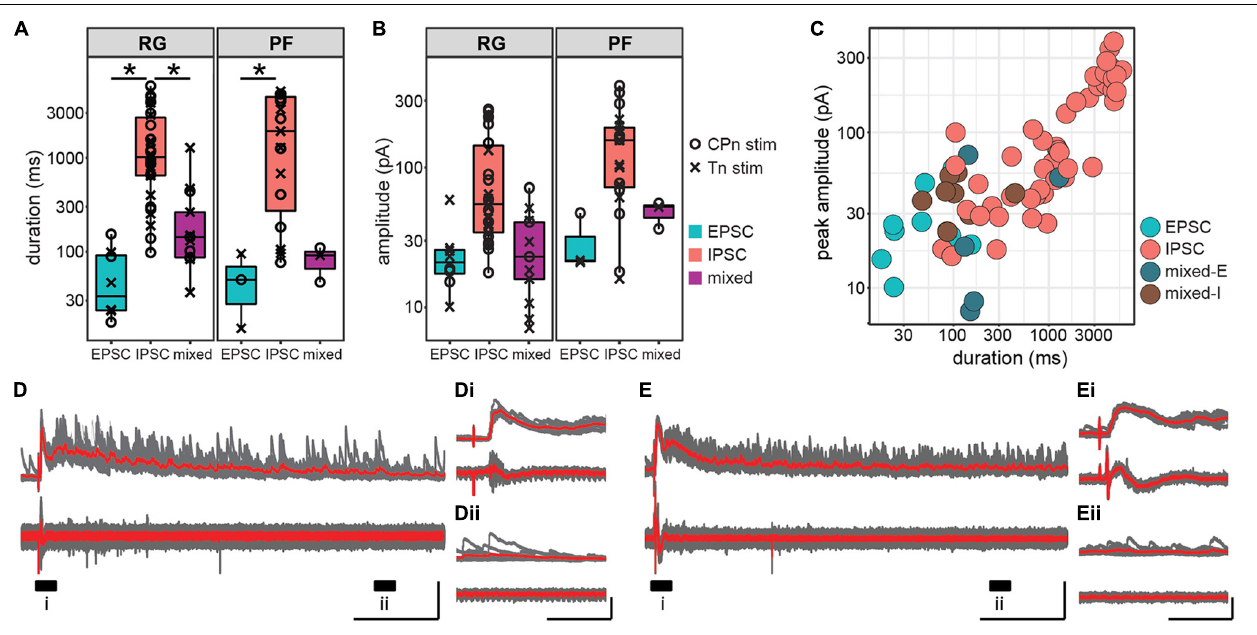
FIGURE 6 | Inhibitory postsynaptic currents in response to ankle afferent stimulation are larger and persist for longer than excitatory postsynaptic currents. (A) Duration of postsynaptic currents measured in the hemisect preparation, plotted on log scale for clarity. Current duration was greater for inhibitory responses than for excitatory responses in both the Shox2 RG population and the Shox2 PF population ( p < 0.05). (B) Absolute peak amplitude of postsynaptic currents, plotted on log scale for clarity. Amplitude for excitatory current components was measured near the inhibitory reversal potential (–50 to –65 mV) and for inhibitory current components near the excitatory reversal potential (0 mV). (C) Peak amplitude and duration of postsynaptic currents in individual Shox2 neurons plotted on a log-log scale. Peak amplitude and response duration are positively correlated (linear regression, adjusted R 2 = 0.81, slope = 0.047, t = 17.84, df = 74, p = 1.60e-28). (D,E) Example traces showing large, long duration inhibitory response to afferent stimulation. Shox2 neuron recording is at the top and ventral root recording at the bottom. Ten individual trials (gray) are overlaid with the average of the trials in red. Labeled regions (i, ii) are expanded in insets (Di,Dii,Ei,Eii) . In these neurons a low-jitter initial response is followed by a prolonged period in which inhibitory currents continue to be received by Shox2 neurons. Vertical scale bars are 200 pA for intracellular recordings and 0.1 mV for extracellular root recordings. Horizontal scale bars are 1000 ms in (D,E) and 100 ms in